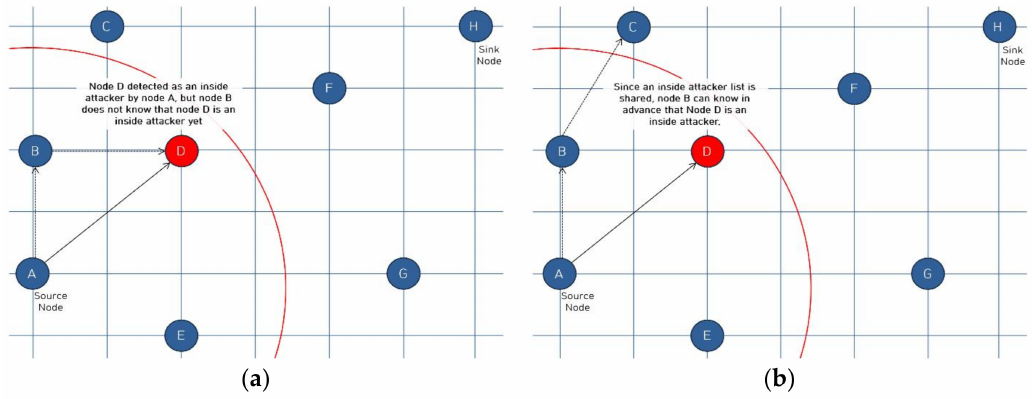
Figure 12. Two defense models in our experiments. ( a ) TM Beta (existing model); ( b ) HF-TM Beta (our proposed